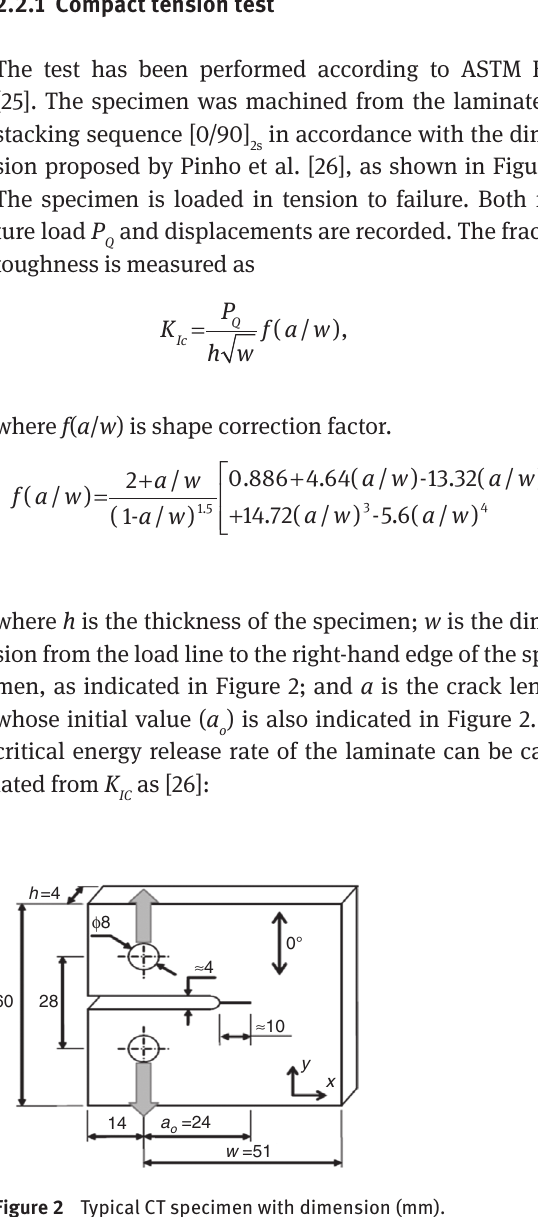
Figure 2 Typical CT specimen with dimension (mm).